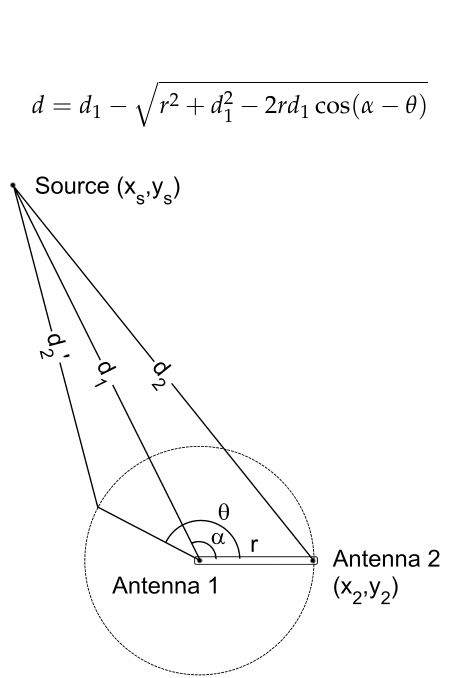
Figure 2. Source and antenna positions to determine the analytic expression of the periodic function θ vs.